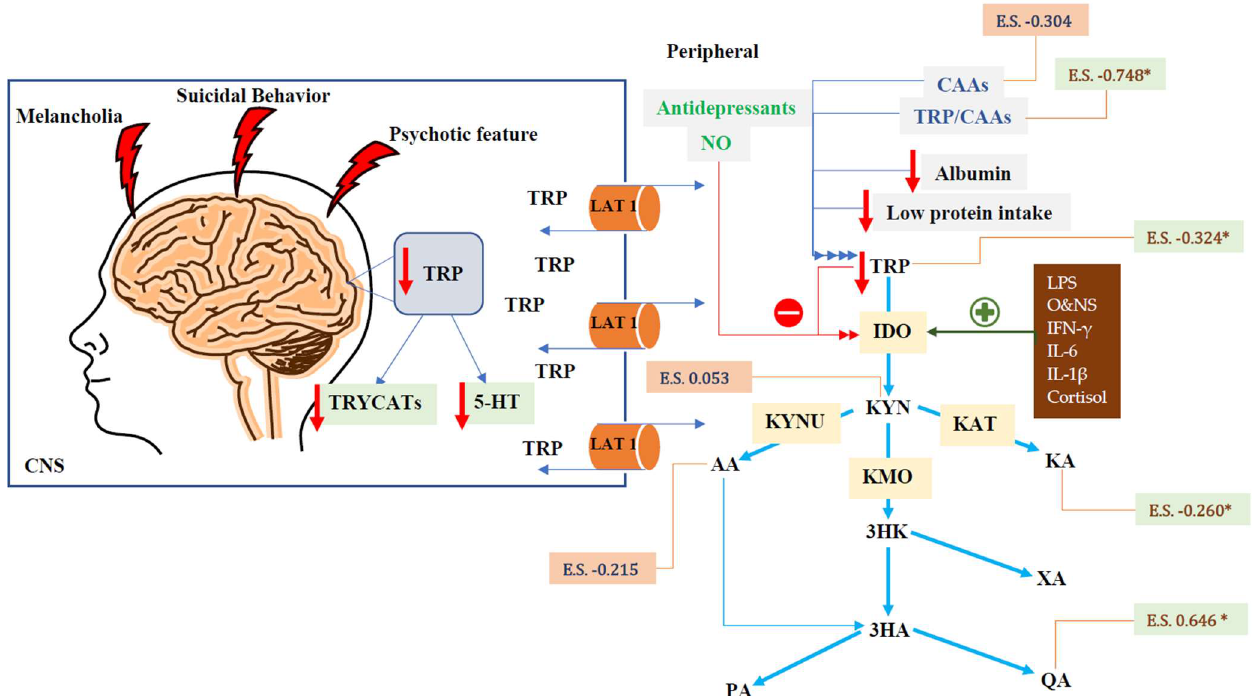
Figure 1. Summary of tryptophan catabolite (TRYCAT) pathway in severe affective disorders. * : significant difference. CNS: central nervous system. TRYCATs: tryptophan catabolites. E.S.: effect size. TRYCAT: tryptophan catabolite. LAT 1: large neutral amino acid transporter 1. IFN-γ: inter-